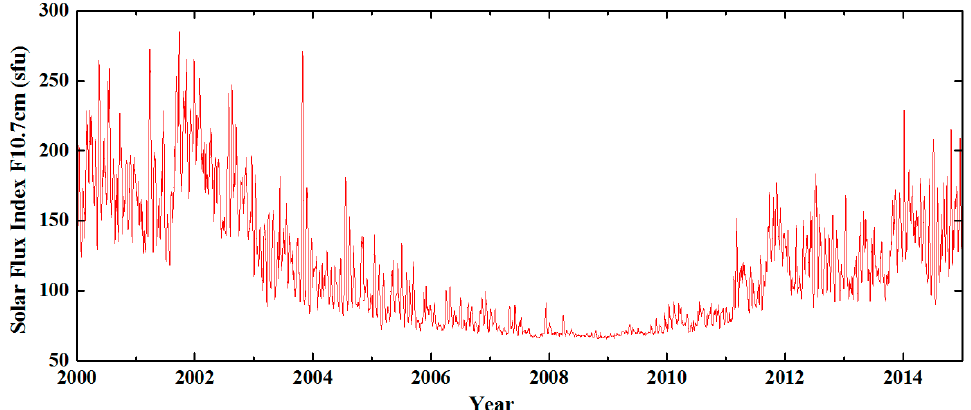
Figure 2. Solar radiation index F10.7 from 2000~2015.